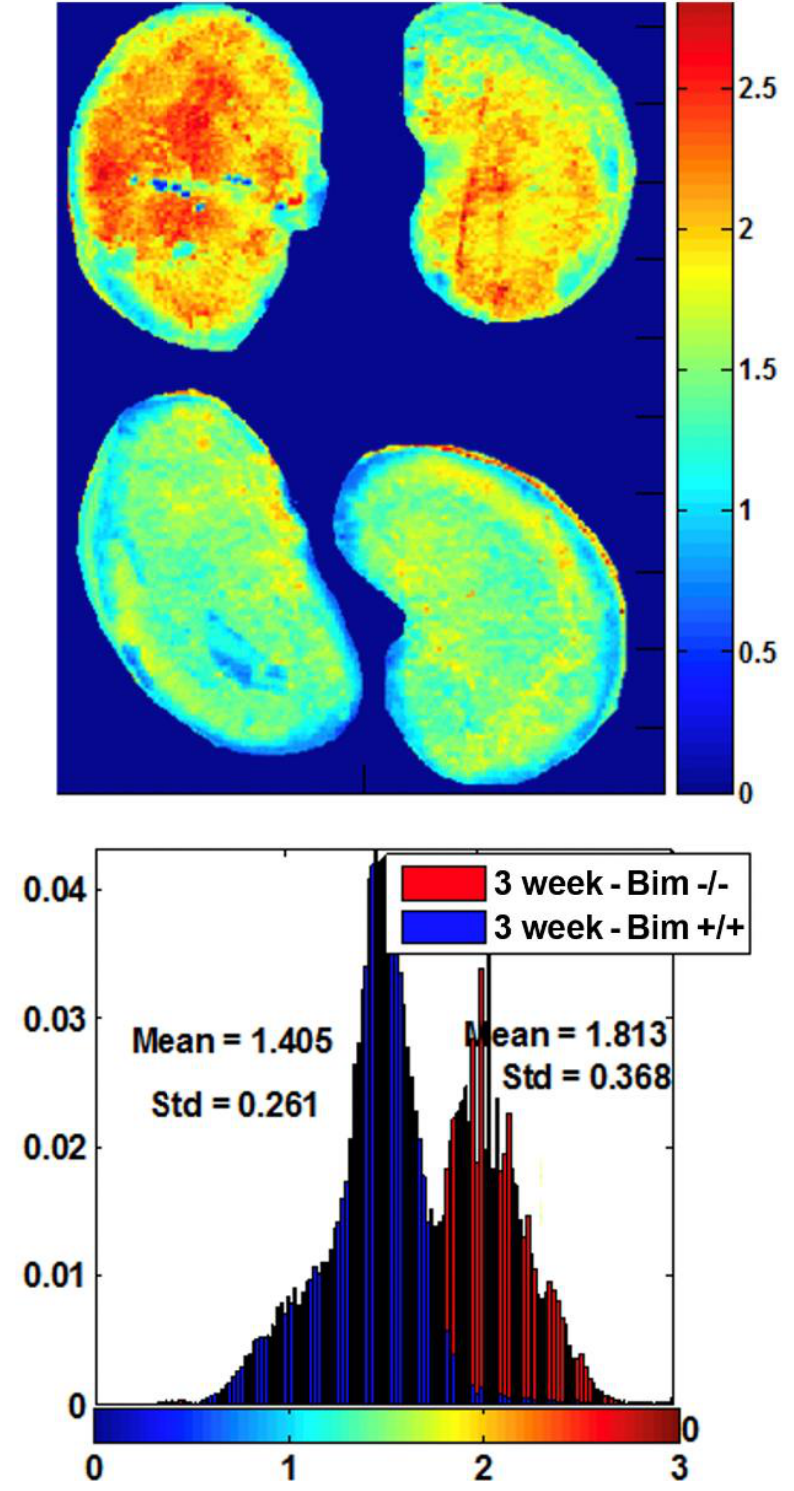
Figure 5. Decreased oxidative stress in kidneys from Bim − / − mice. Top panel: Low resolution NADH redox ratio image of kidneys from Bim − / − (top row) wild-type control mice (bottom row). Bottom panel are histograms of the redox ratio distribution in each group. Please note decreased oxidative stress in the absence of Bim. Data representative of six mice.